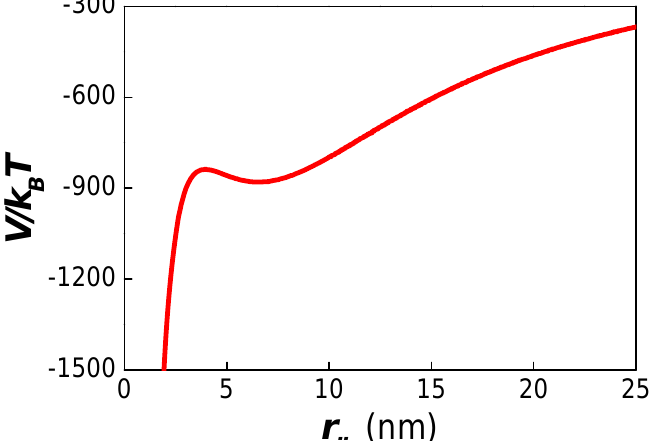
Figure 7. Potential energy between two spherical drops of bitumen ( R surface charge of σ = 13.95 mCoul/m 2 ( Ψ of the solution is equal to 1.4 x 10 -2